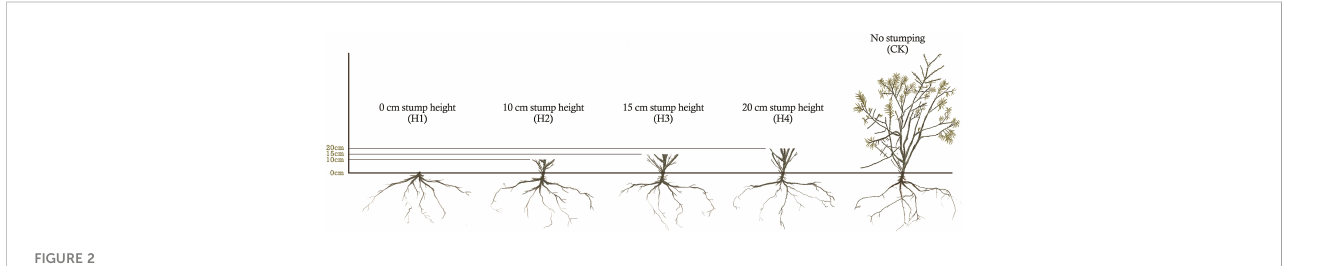
FIGURE 2 Schematic diagram of different stump heights treatment of H. rhamnoides .